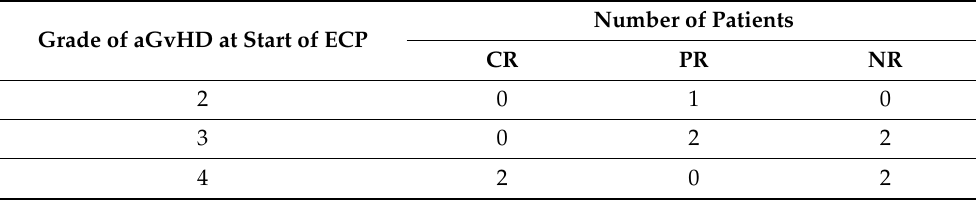
Figure 3. Patient with NR. Corticosteroids had to be increased during ECP due to hematochezia. Diarrhea decreased over time but no significant treatment response was observed in this patient. Table 2. Disease severity of intestinal aGvHD and therapy